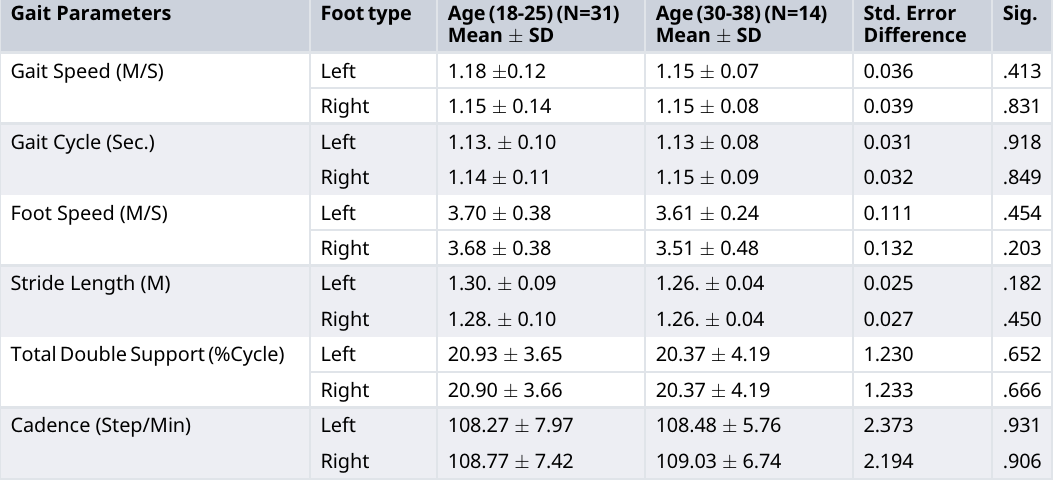
Table 3. A comparative analysis across age